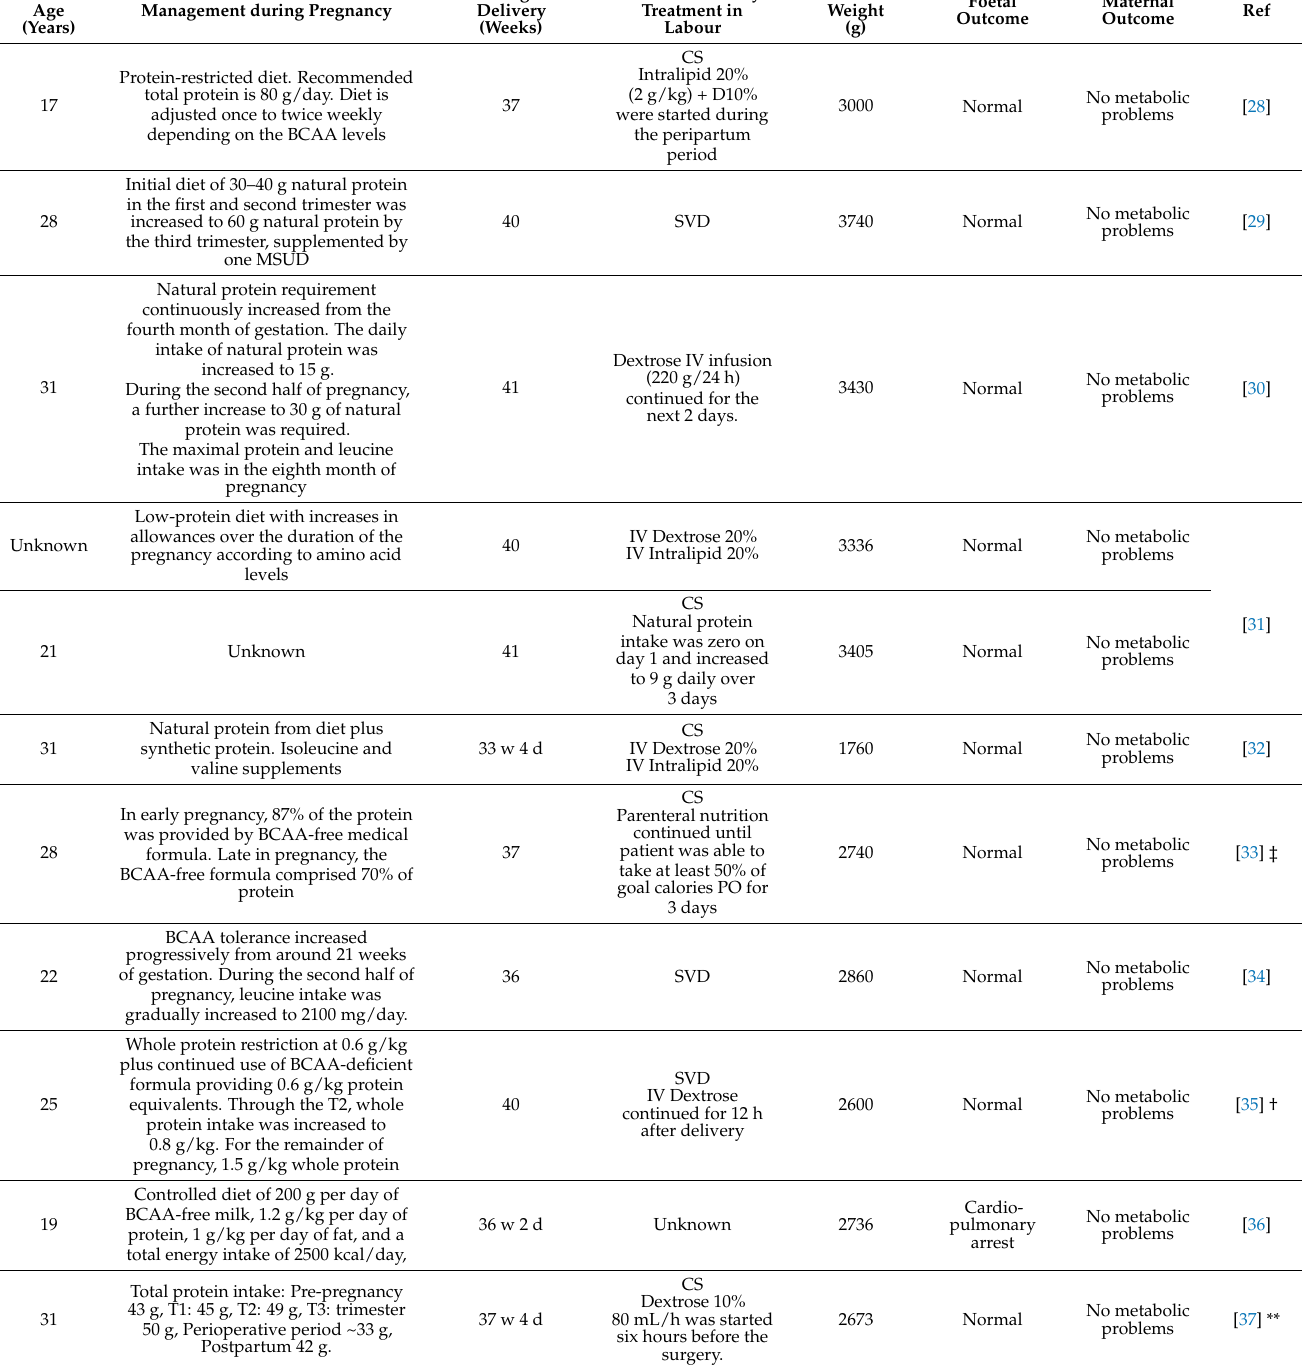
Table 2. Published literature on pregnancies in